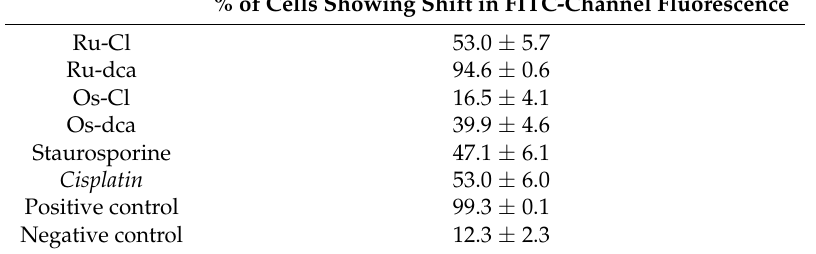
Table 4. The results (given as % cell populations) of the cytochrome c release studied by flow cytometry at the A2780 cells treated for 24 h by the IC 50 concentrations of complexes Ru-Cl , Ru-dca , Os-Cl and Os-dca ( cisplatin and staurosporine were used for comparative purposes). The untreated A2780 cells were employed as the negative control, while the cells applied with the Anti-IgG1-FITC Isotype represented the positive control. The data are given as arithmetic means ± SD from three independent